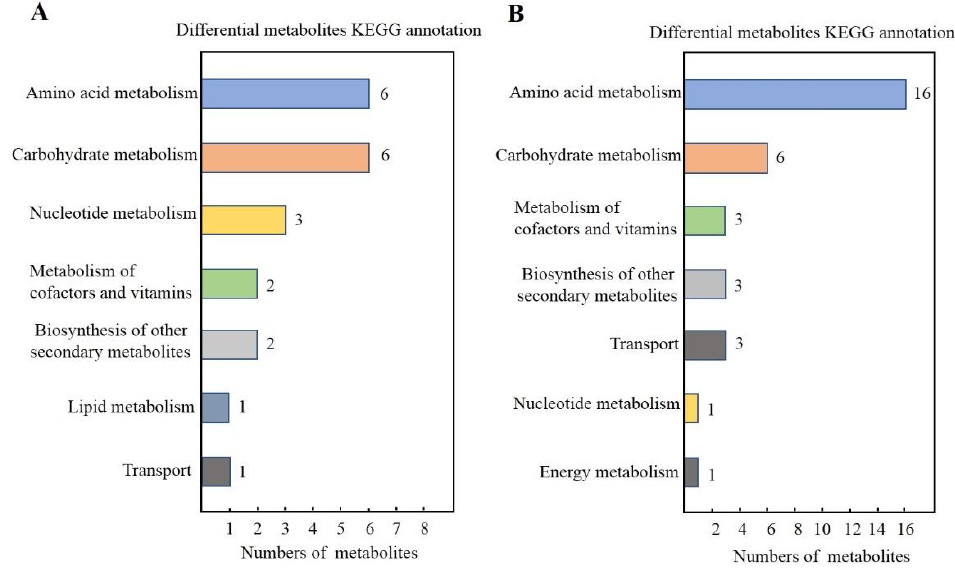
Figure 4. KEGG classification of differential metabolites between “G32” and “J120”. ( A , B ): KEGG classification of metabolites differentially accumulated in “J120” and “G32” in NEG and POS modes, respectively.